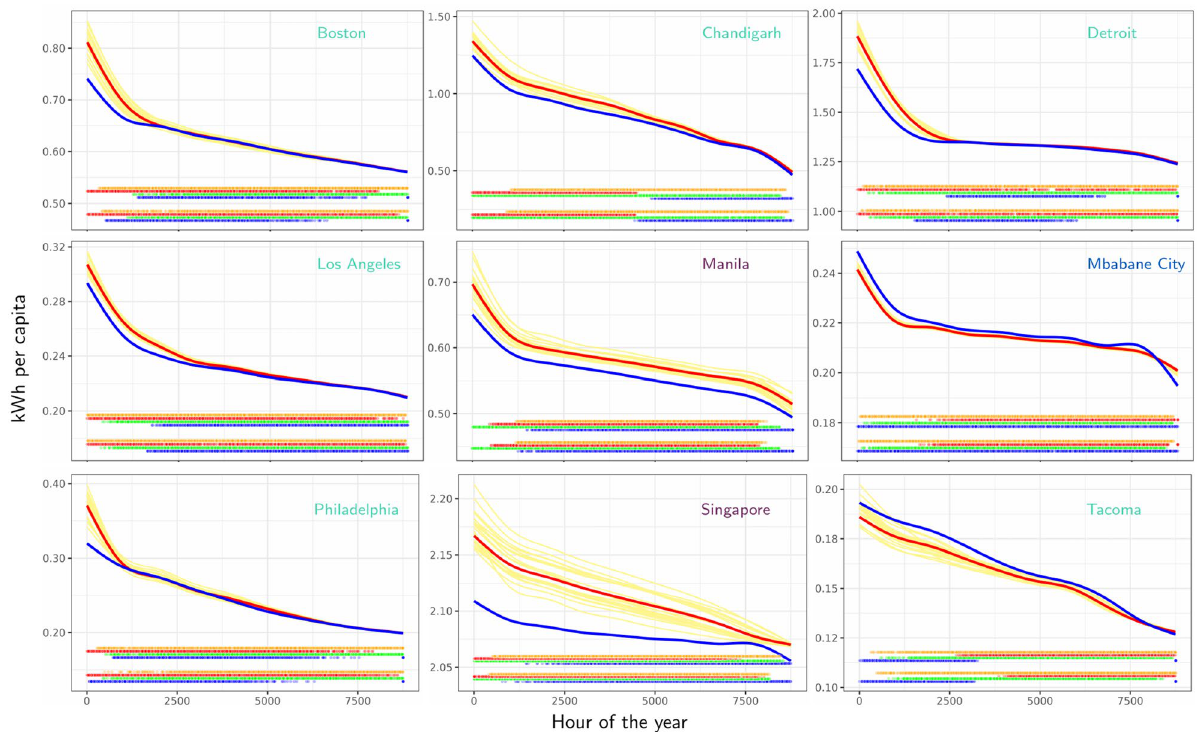
Figure 6. Current and projected 2050 load duration curves (LDCs) and seasonal distribution of load for a subset of cities. For each city, LDCs are shown for the current climate (blue), individual GCM simulations of RCP 8.5 warming (yellow), and the multi-GCM median (red). Colored panels illustrates each city’s seasonal distribution of hourly demand in the current climate (bottom) and RCP 8.5 warming (top), blue: winter, red: summer, green: spring, orange: